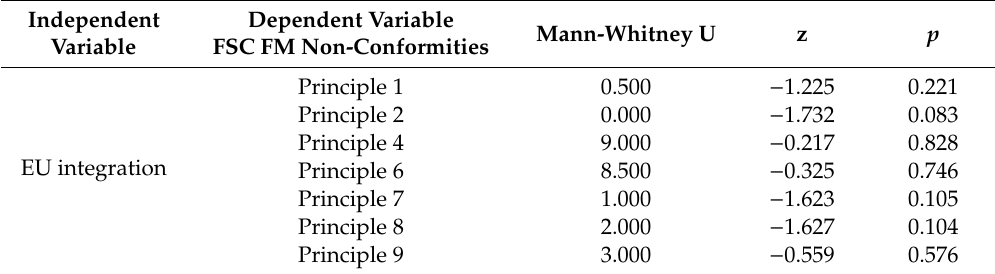
Table A3. Statistical results of Mann-Whitney U test